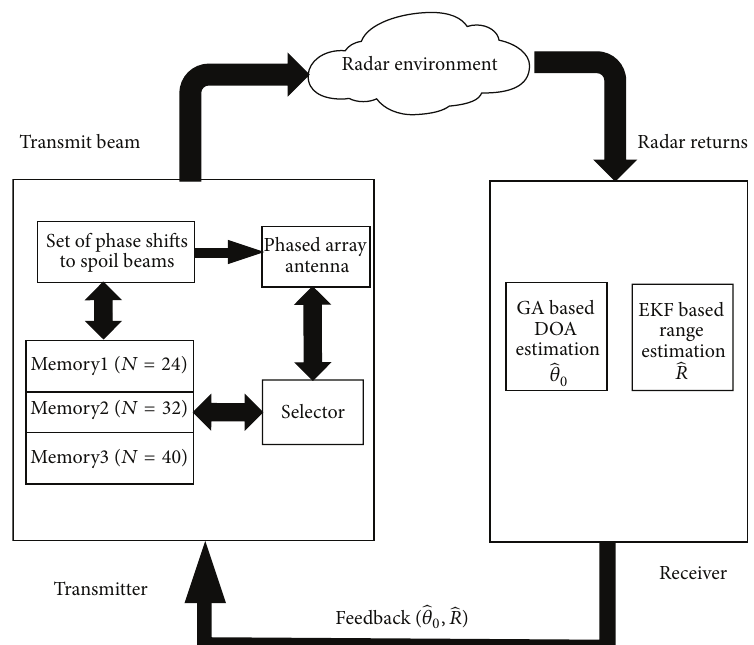
Figure 3: Block diagram of the proposed radar.